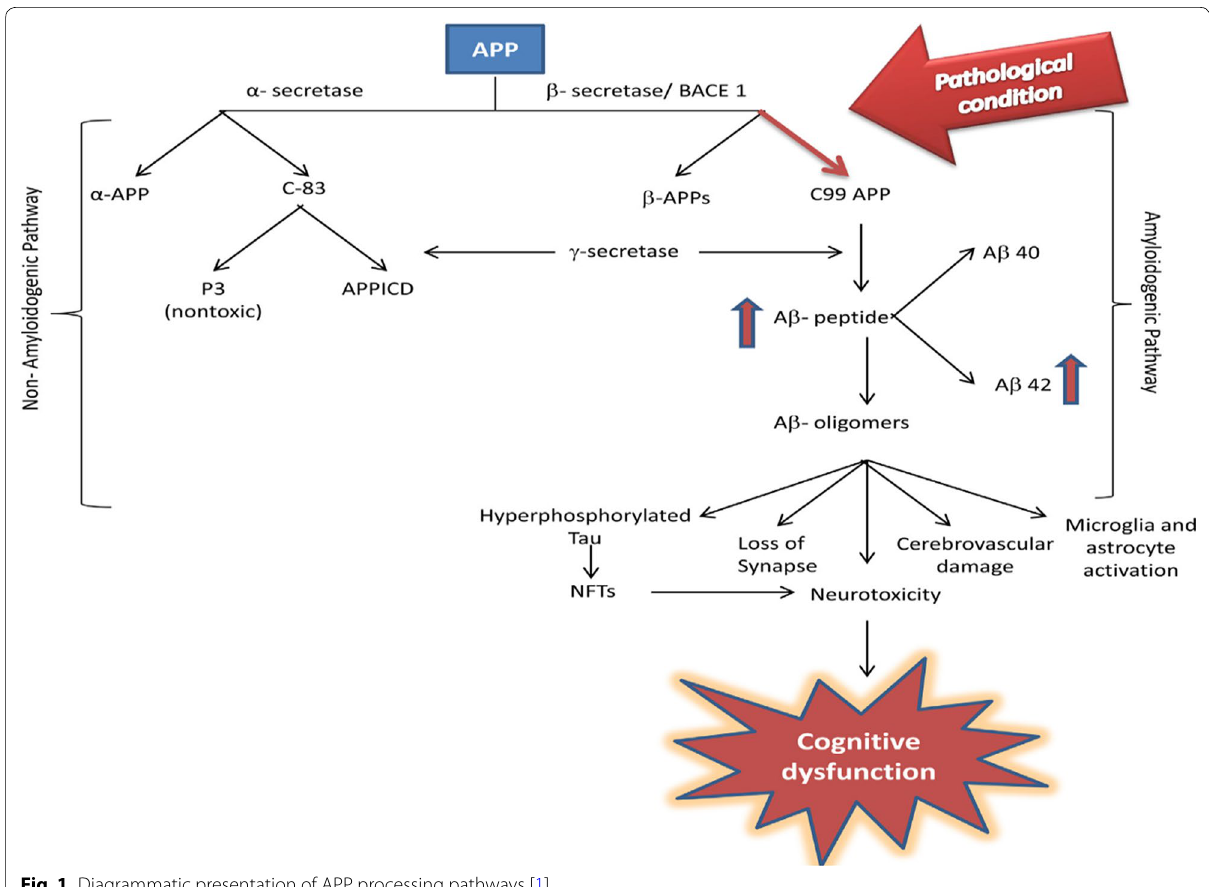
Fig. 1 Diagrammatic presentation of APP processing pathways [1]